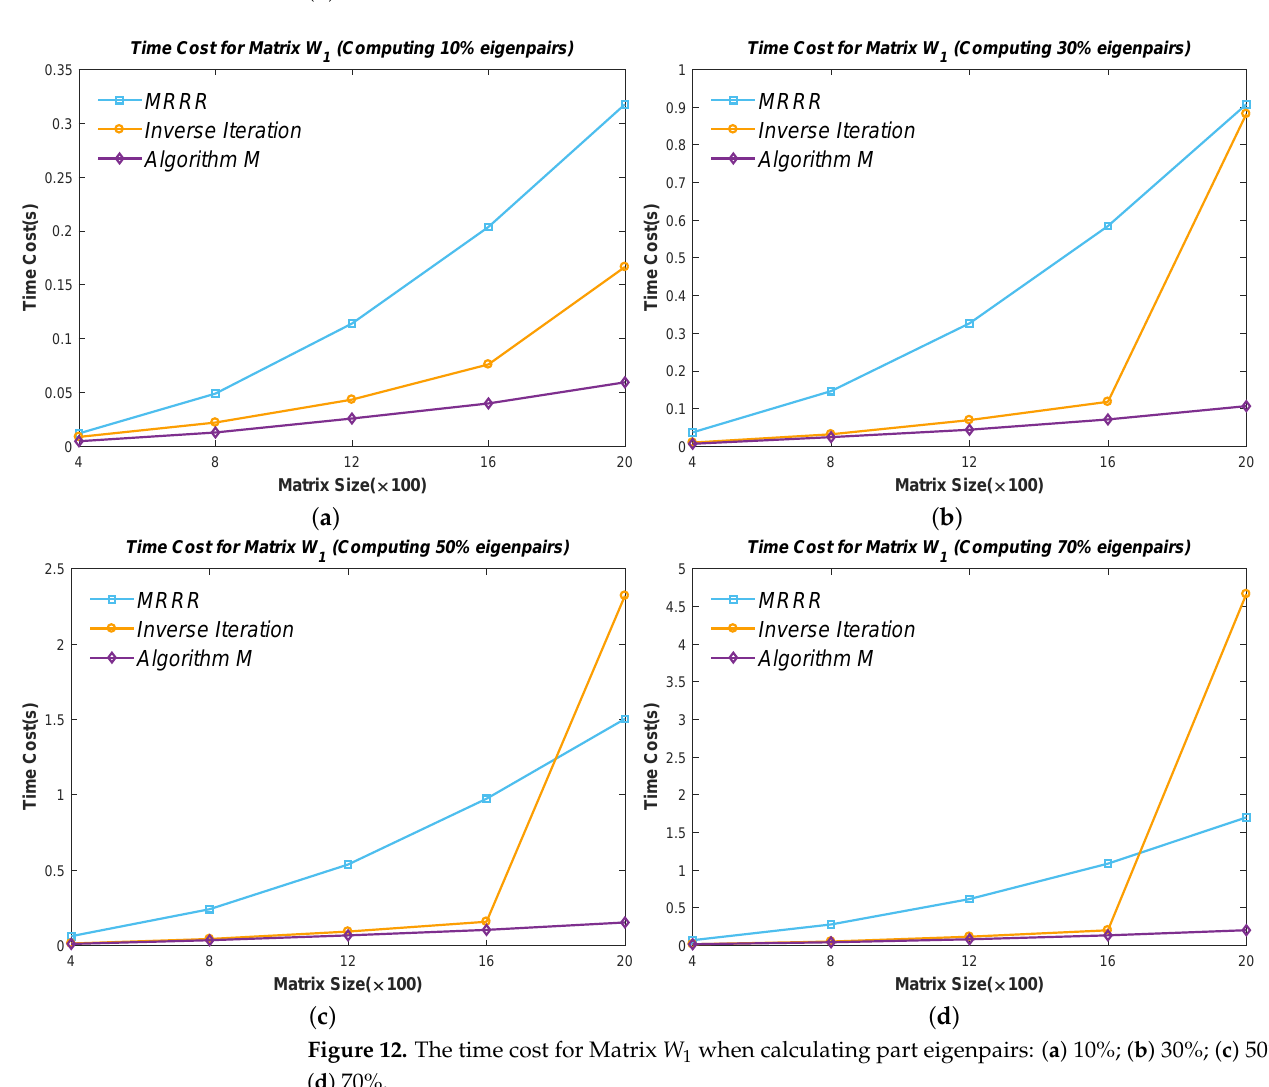
Figure 12. The time cost for Matrix W 1 when calculating part eigenpairs: ( a ) 10%; ( b ) 30%; ( c ) 50%; ( d )